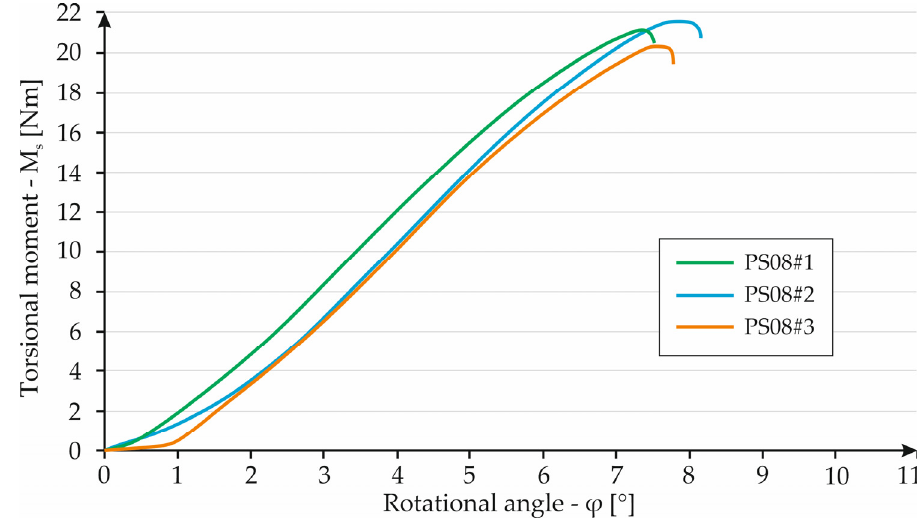
Figure 15. Graph showing the dependence of torque on torsion angle for S08 specimens.